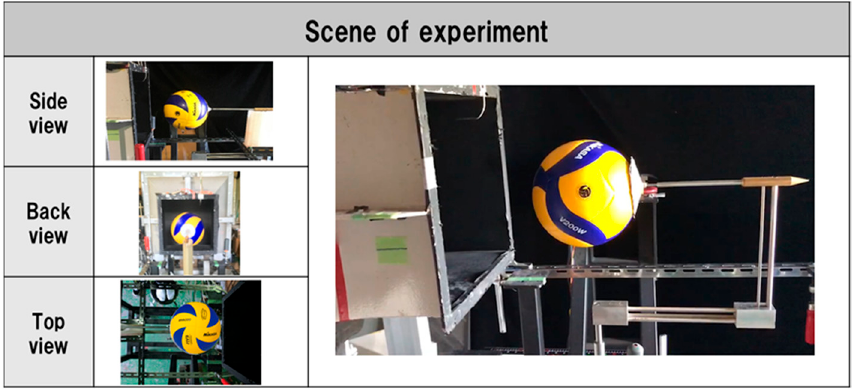
Figure 2. Appearance of fluid force